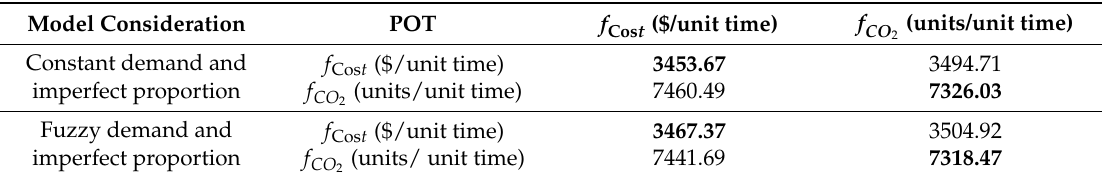
Table 3. Payoff table for